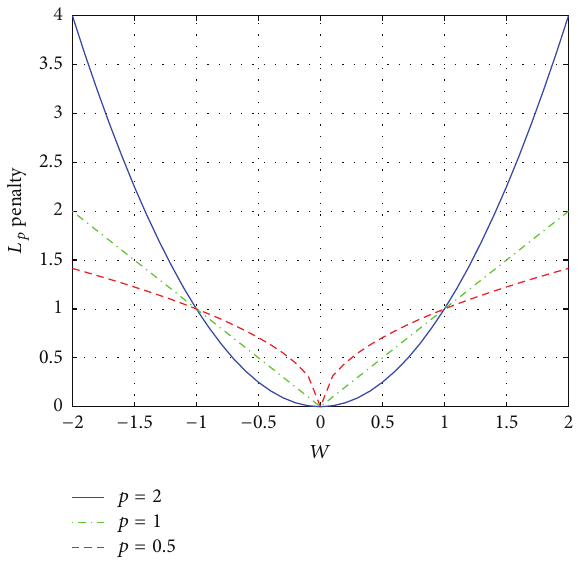
Figure 1: 𝐿 𝑝 penalty in one